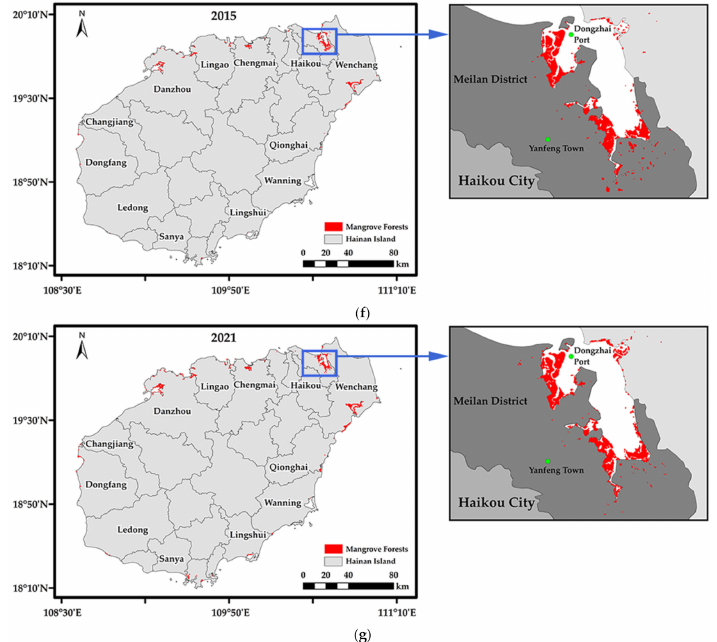
Figure A2. Classification results of Res-UNet machine-learning. ( a ) 1991; ( b ) 1996; ( c ) 2000; ( d ) 2007; ( e ) 2010; ( f ) 2015; ( g )